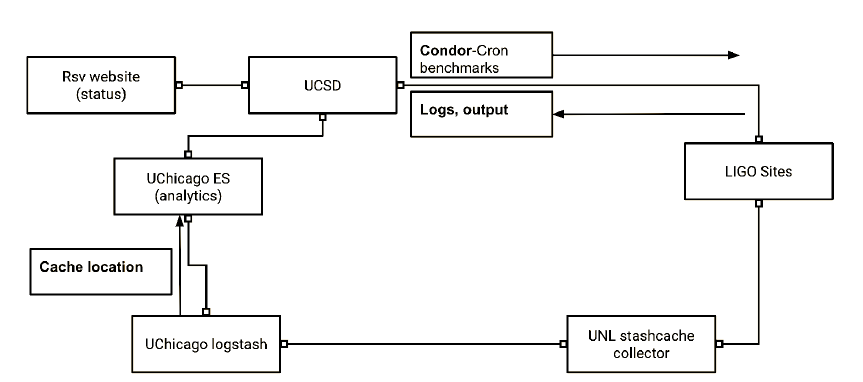
Figure 9. Infrastructure to measure dependency of IGWN job e ffi ciencies to StashCache node avail- ability and proximity to the compute site. Data are indexed in an Elastic Search instance at UChicago and displayed over a Kibana